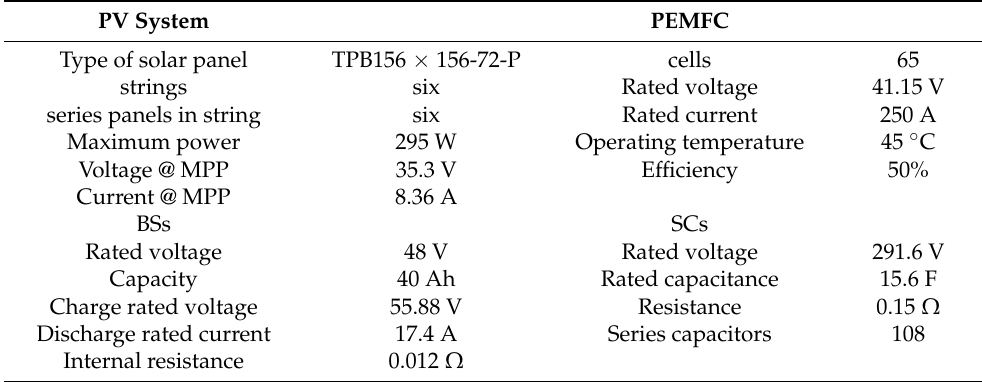
Figure 6. Configuration of hybrid PV/PEMFC/BSs/SCs system. Table 2. The elements of a hybrid system’s electrical